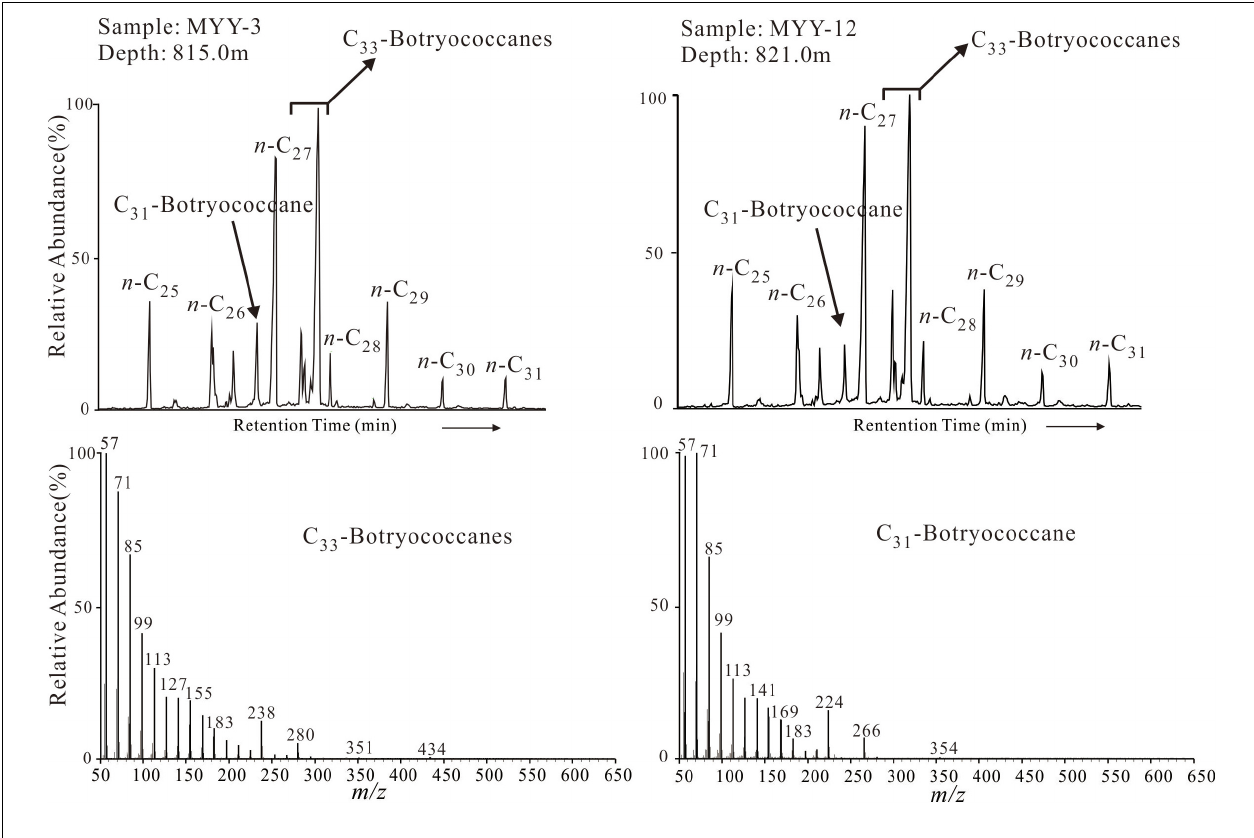
FIGURE 6 | The identification chromatograms of botryococcanes in the oil shale